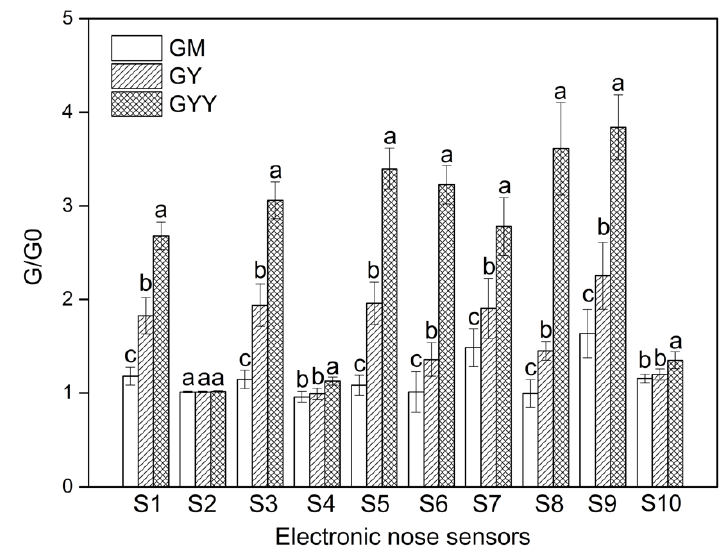
Figure 4. Response values of E-nose sensor arrays to aroma compounds from various groups of goat milk samples. G/G0 represents the ratio of the volatile conductivity G to the initial conductivity G0. The error bars represent the standard deviation of three replicates.